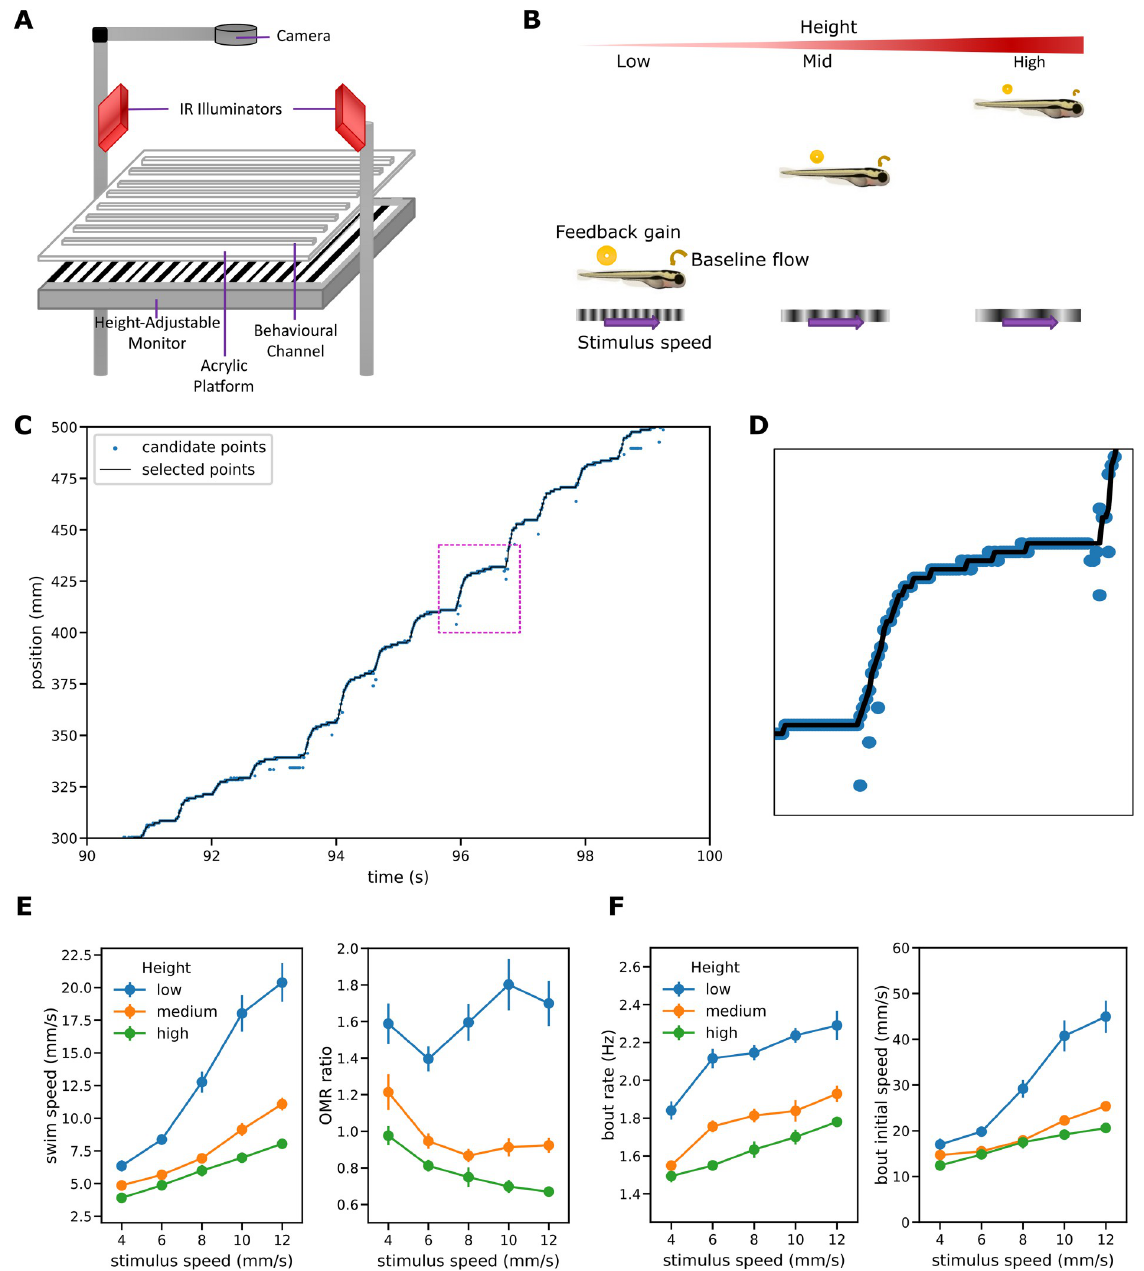
Fig 2. Free swimming setup and the OMR regulation experiment. (A) Schematic illustration of the experimental apparatus. (B) OMR regulation procedure. Each fish is tested at one of three different heights and the same set of stimulus speeds. For a given stimulus speed, baseline optic flow–the optic flow experienced when the fish is at rest–and feedback gain both decrease as the height increases. (C) Sample trace showing position of the fish from the start of the channel. The light blue points show possible positions for the center of mass at each time step; the black line shows the positions selected as most probable by the tracking algorithm from those candidates. Dotted rectangle shows region shown in (D). (D) Magnified portion of trace containing a single bout. (E) Mean swim speed and OMR ratio for the OMR regulation procedure. OMR ratio is defined as the ratio of the mean swim speed observed during OMR trajectories to the speed of the grid stimulus. Error bars here and elsewhere: standard error. (F) Bout patterns for the OMR regulation procedure.